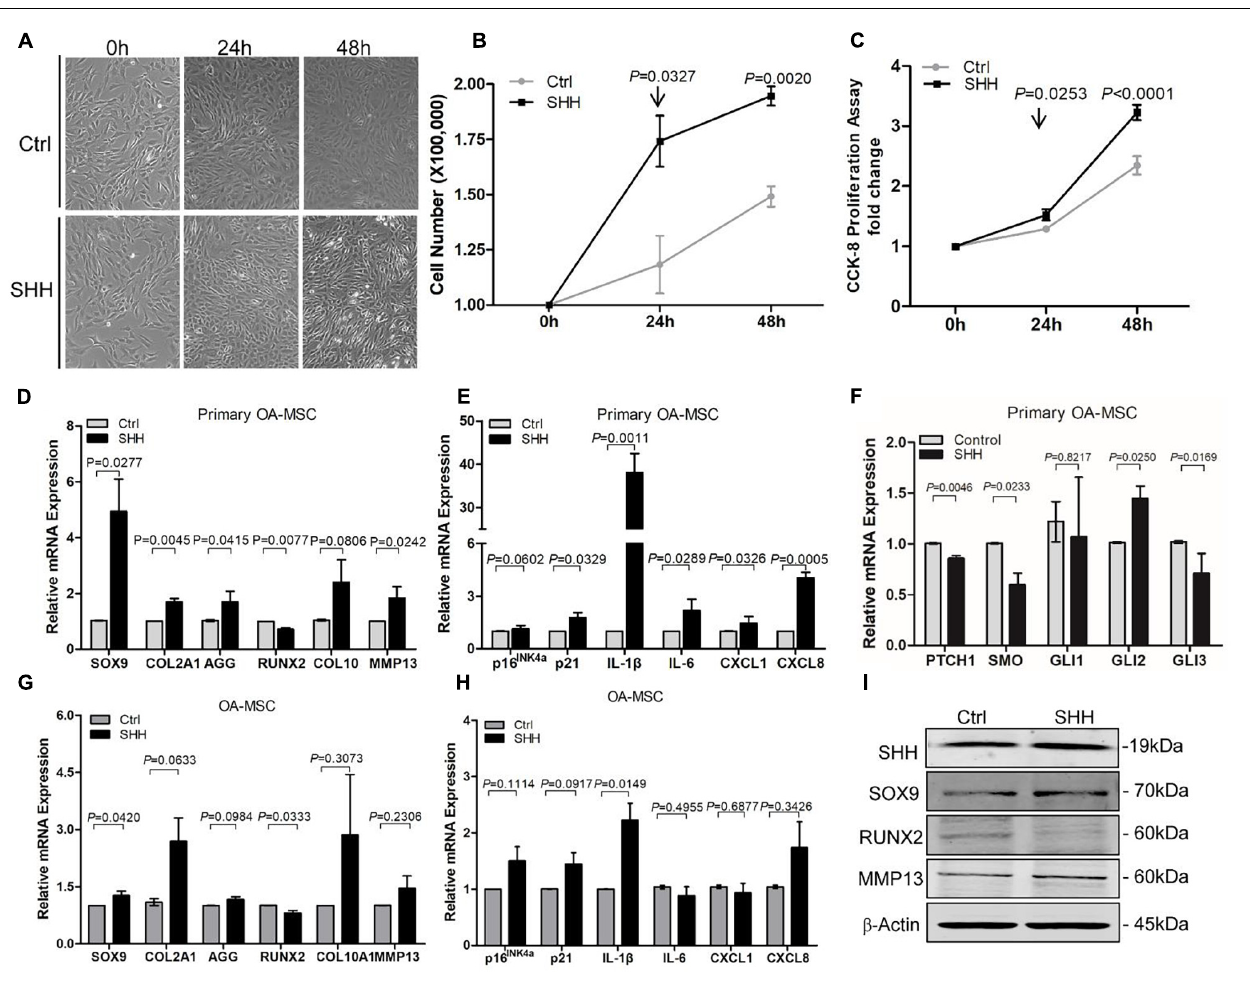
FIGURE 2 | Sonic hedgehog (SHH) promoted osteoarthritis mesenchymal stromal cell (OA-MSC) proliferation and gene expression of the markers for chondrogenesis, hypertrophy, catabolism, senescence, and senescence-associated secretory phenotype (SASP). (A) Micrographs of primary OA-MSCs and their treatment with human SHH recombinant protein for 24 and 48 h. Images are representative of cell culture samples in triplicates. Scale bar = 125 µ m. (B) Cell number change of OA-MSC in response to human recombinant SHH incubation for 24 and 48 h. n ≥ 4 individual biological samples. (C) Cell proliferation rate of OA-MSC in response to human recombinant SHH incubation for 24 and 48 h. Cell proliferation rate was quantified by the CCK-8 proliferation assay. n = 5 biological replicates. Real-time RT-PCR analysis of transcripts encoding markers of chondrogenesis and hypertrophy (D) , cell senescence, and SASP (E) , hedgehog (HH) signaling (F) in primary OA-MSC. 18S RNA was used as a reference gene for RT-PCR amplification. p -values were indicated n = 3. Real-time RT-PCR analysis of transcripts encoding markers of chondrogenesis and hypertrophy (G) , cell senescence, and SASP (H) , in OA-MSC cell line. 18S RNA was used as a reference gene for reverse transcriptase-polymerase chain reaction (RT-PCR) amplification. p -values were indicated ( n = 3). (I) Western blot analysis of protein levels of SHH, SOX9, RUNX2, and MMP13 in OA-MSC cell line in response to human recombinant SHH treatment. β -actin was used as a protein loading control. Data shown are representative of three biological samples ( n =